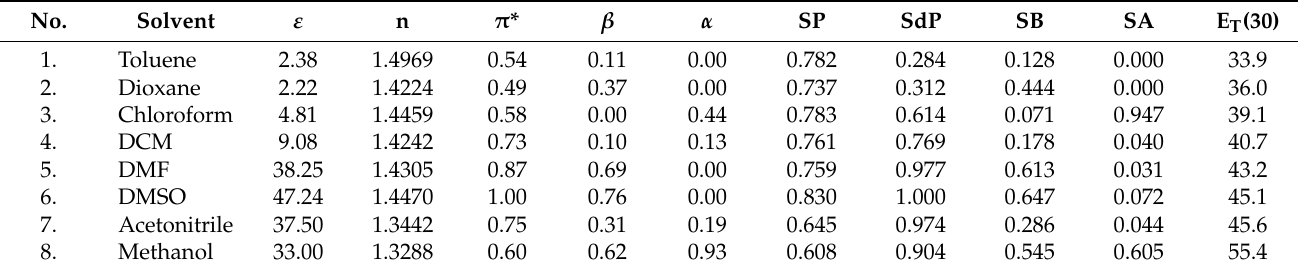
Table 4. Solvents and solvent properties.